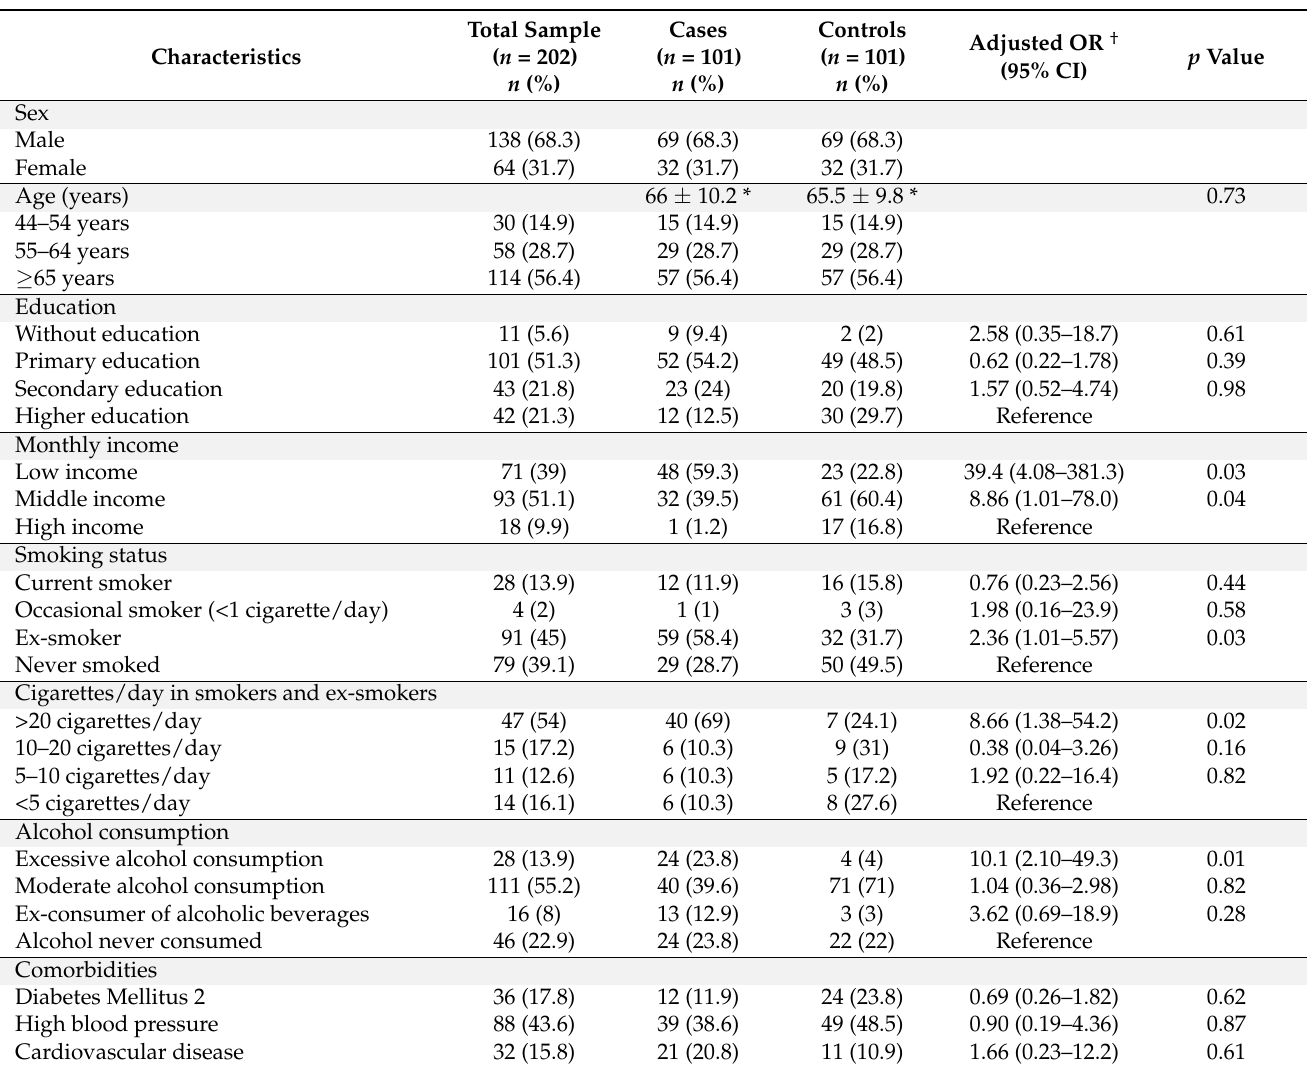
Table 1. Sociodemographic characteristics of cases and controls and factors associated with head and neck